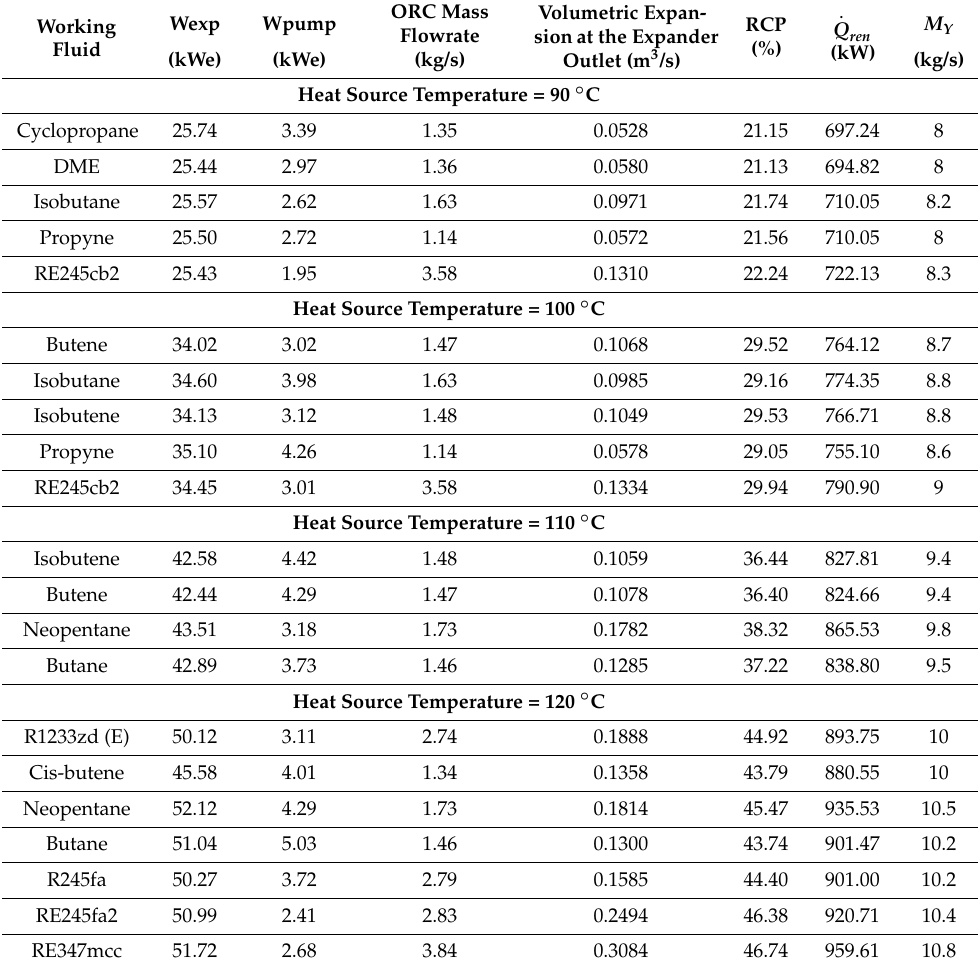
Table 7. Baseline results at various heat source